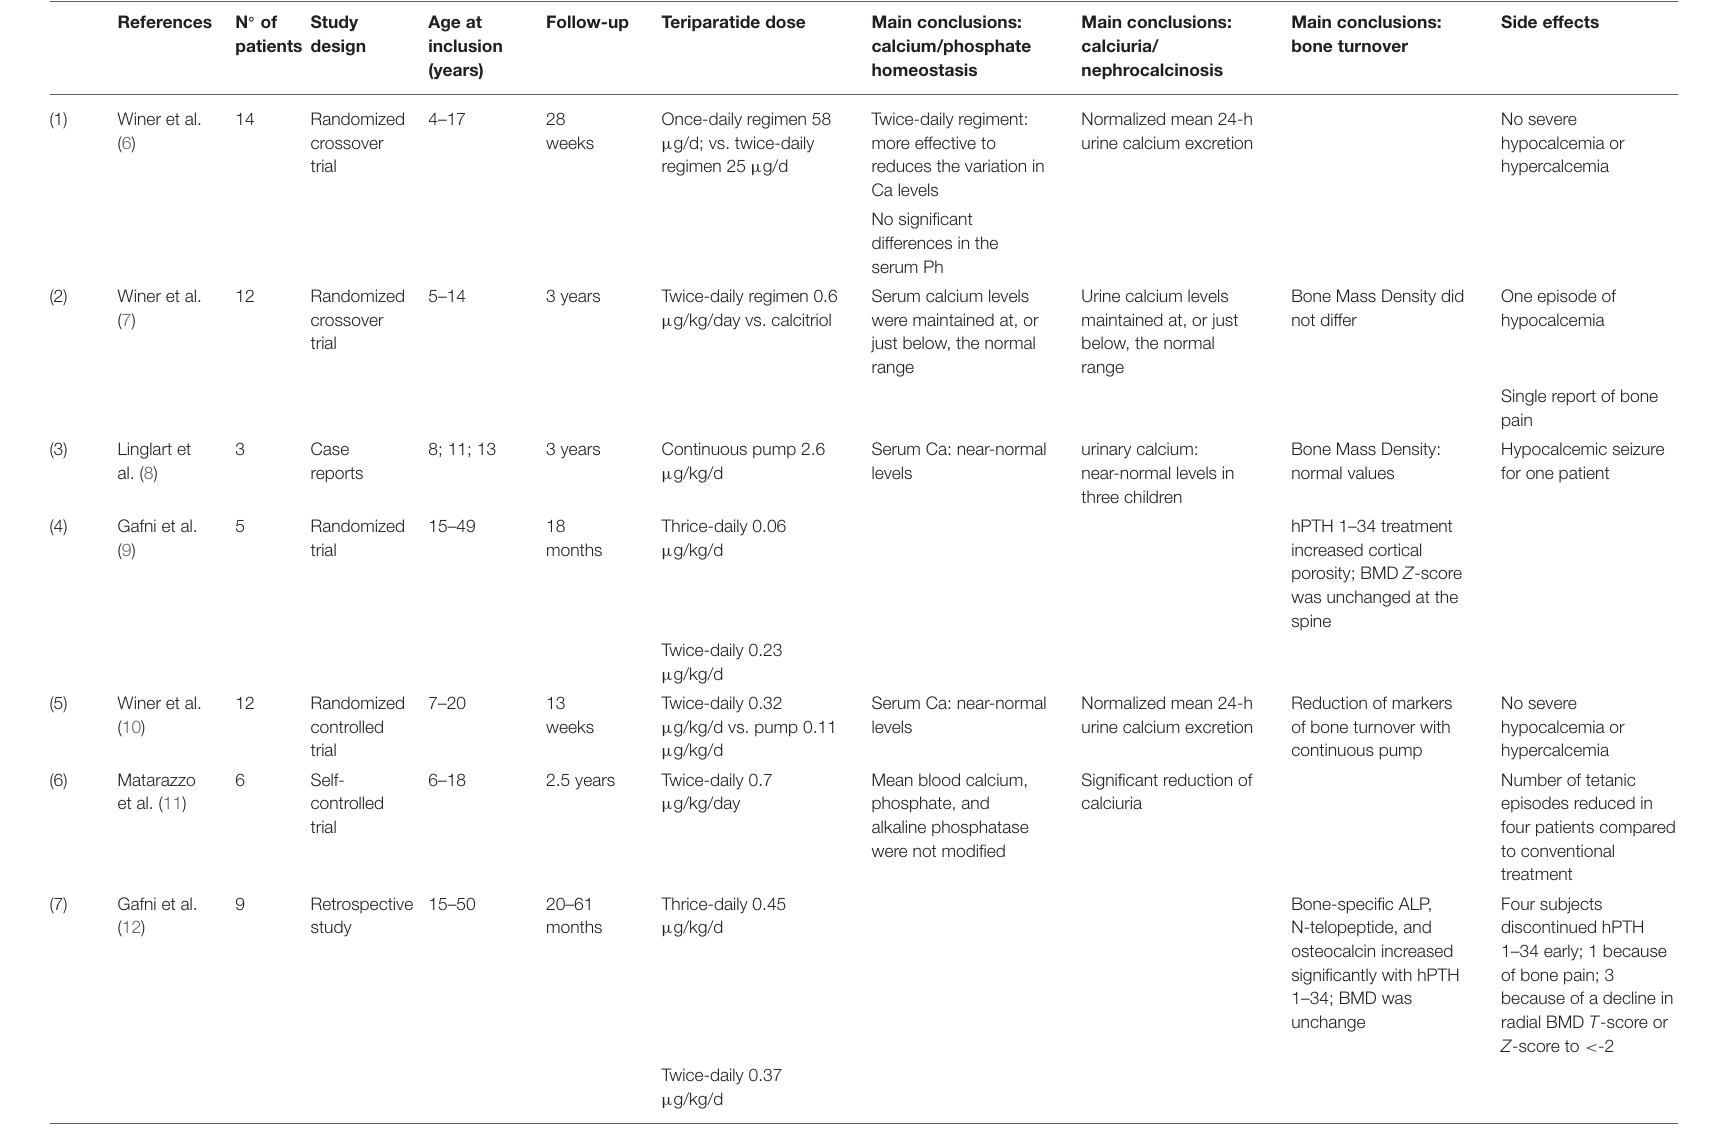
TABLE 5 | Summary of the pediatric studies reporting the use of teriparatide in